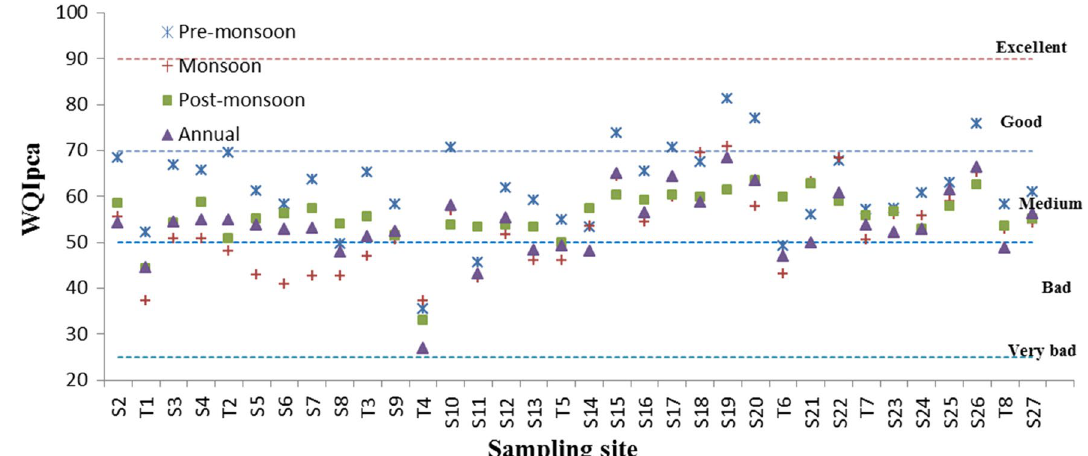
Fig. 9 Spatial and temporal variations of WQI